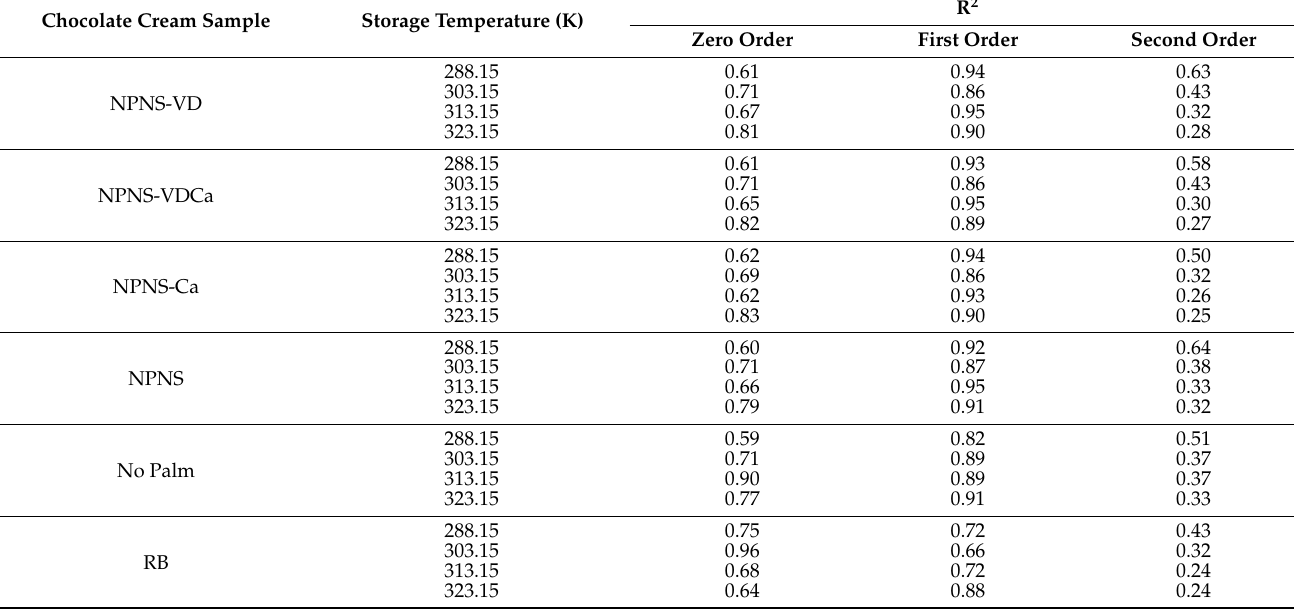
Table 2. Coefficients of correlation R2 for peroxide value of chocolate spread for zero, first, and second-order kinetic